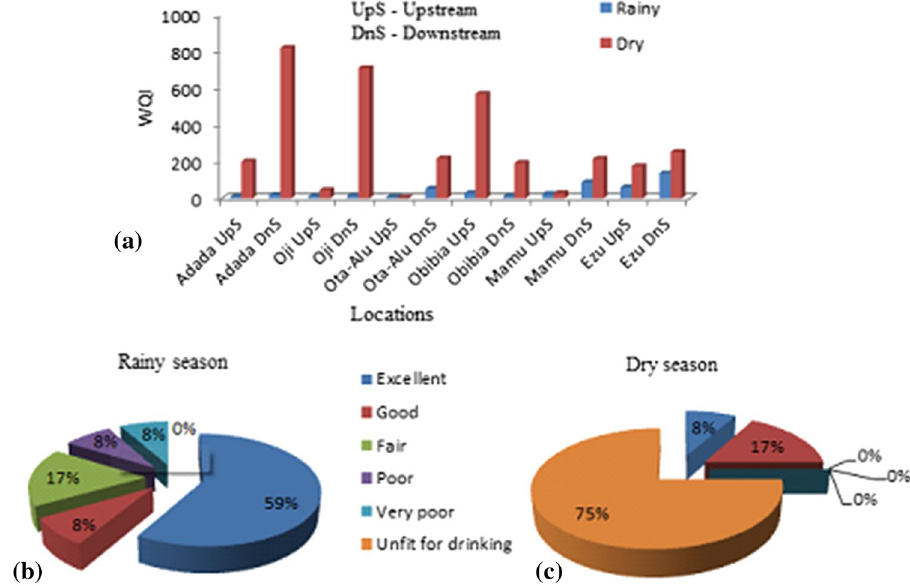
Fig. 8 Statistical pictogram of Mamu River basin water